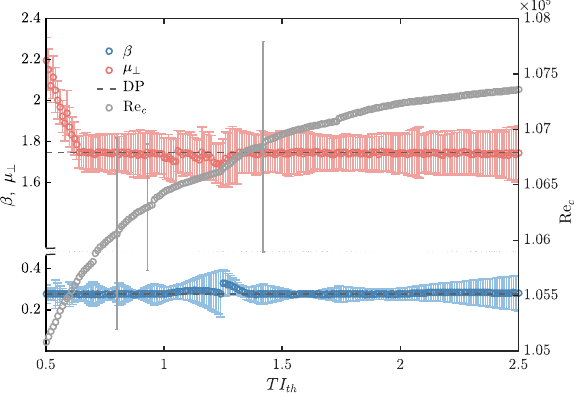
FIG. 7. Systematic analysis of the critical exponents sensitivity to the threshold of turbulence intensity imposed in the directed percolation model: the exponent β and the transverse fractal dimension μ ⊥ . The dashed lines indicate the theoretical value of the exponents in directed percolation. For a turbulence intensity > 0 . 64 , the critical exponents of directed percolation are TI th obtained within numerical errors (see text). Gray symbols show the dependence of the critical Reynolds number on the threshold. For the sake of clarity, only three illustrative error bars of Re c are